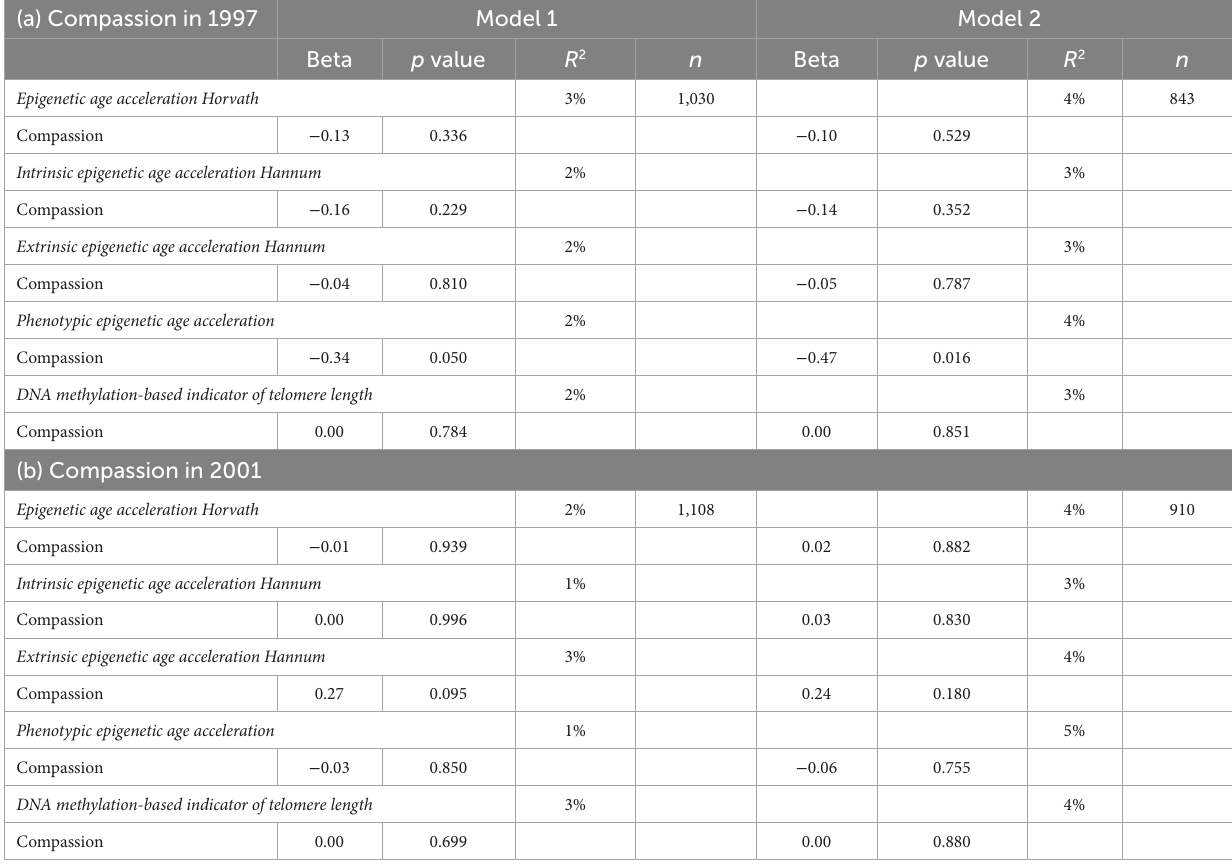
TABLE 3 Linear regressions of compassion in (a) 1997 and (b) 2001 Predicting five DNAm epigenetic aging indicators in 2011. (a) Compassion in